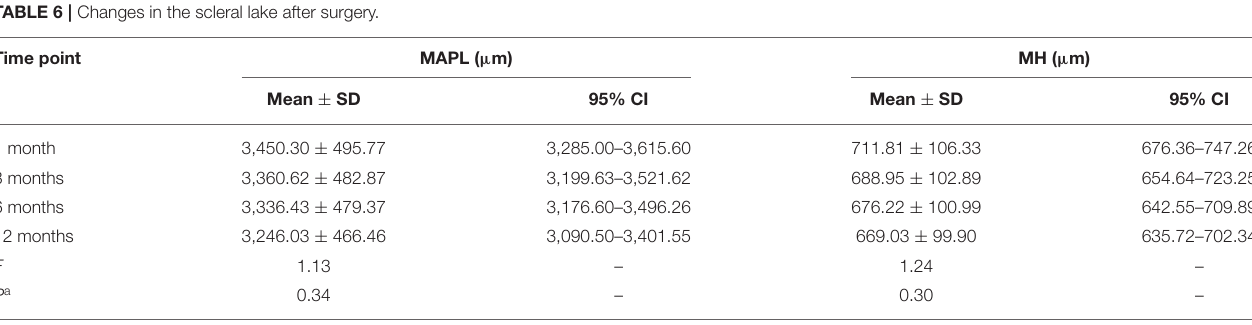
TABLE 6 | Changes in the scleral lake after surgery.